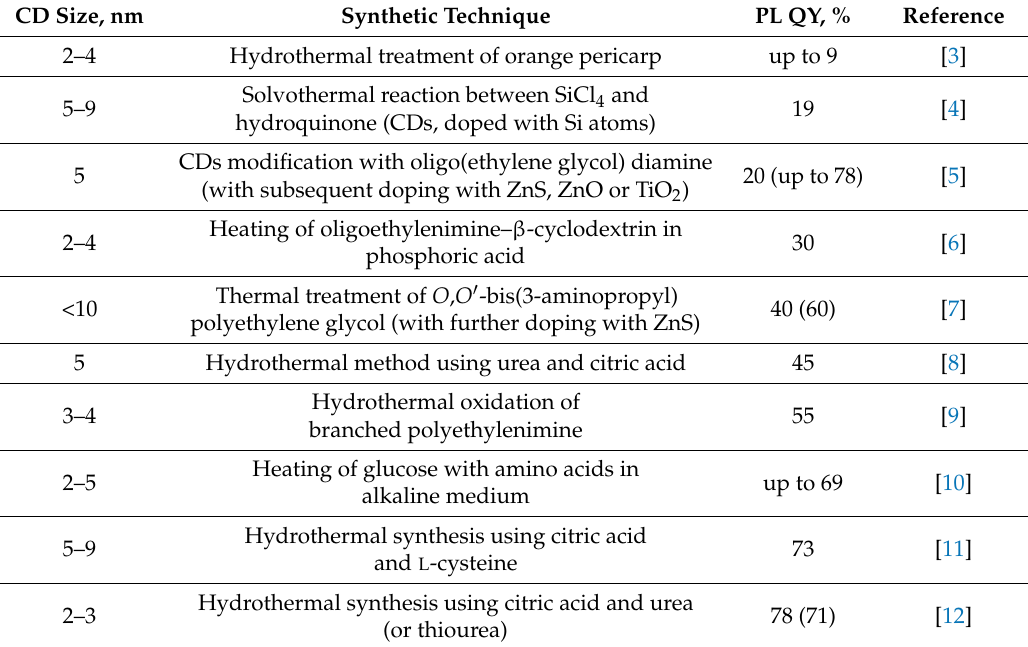
Table 1. Photoluminescent characteristics of carbon dots synthesized by different